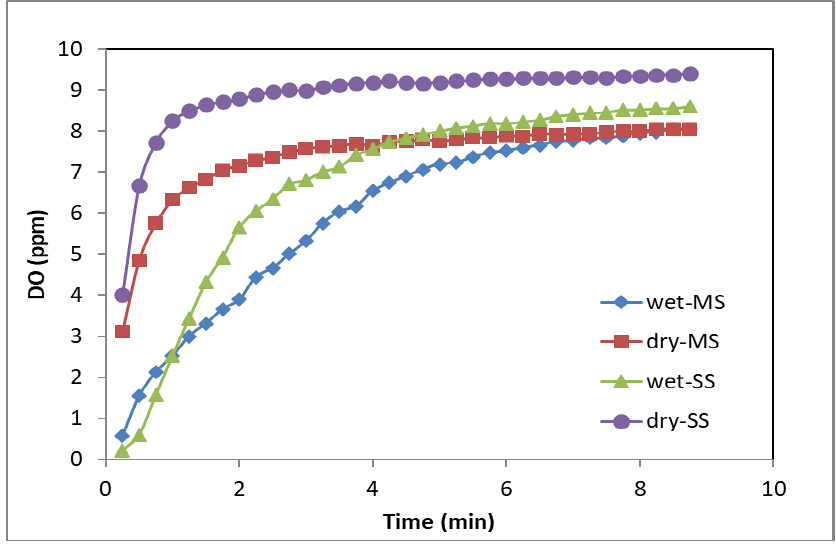
Figure 3. DO concentrations in the pulp during flotation for different milling conditions.